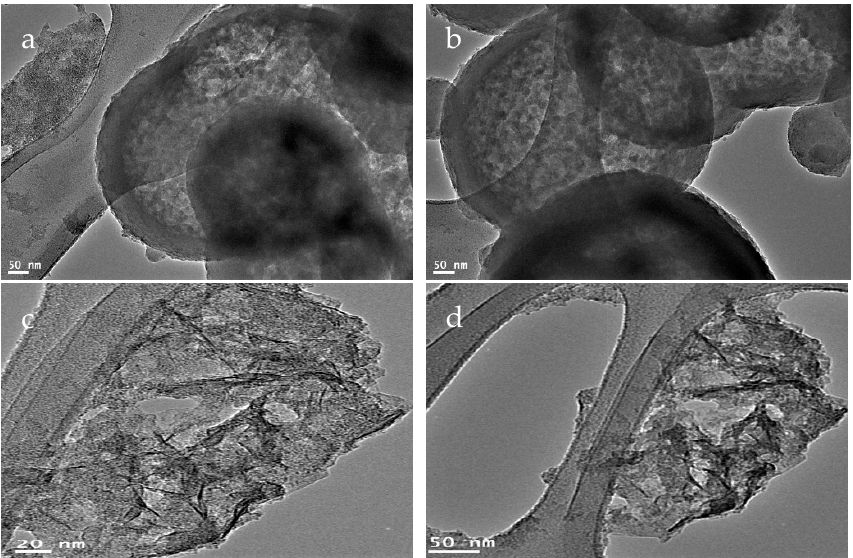
Figure 5. TEM images of the prepared nanocomposite NC-2 ( a ) first location, ( b ) second location, ( c ) third location and ( d ) fourth location.